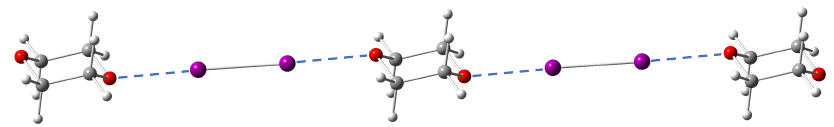
Figure 7. Optimized crystal model structure showing the halogen bonding H1 between diiodine and acceptor molecule H within the infinite alternating